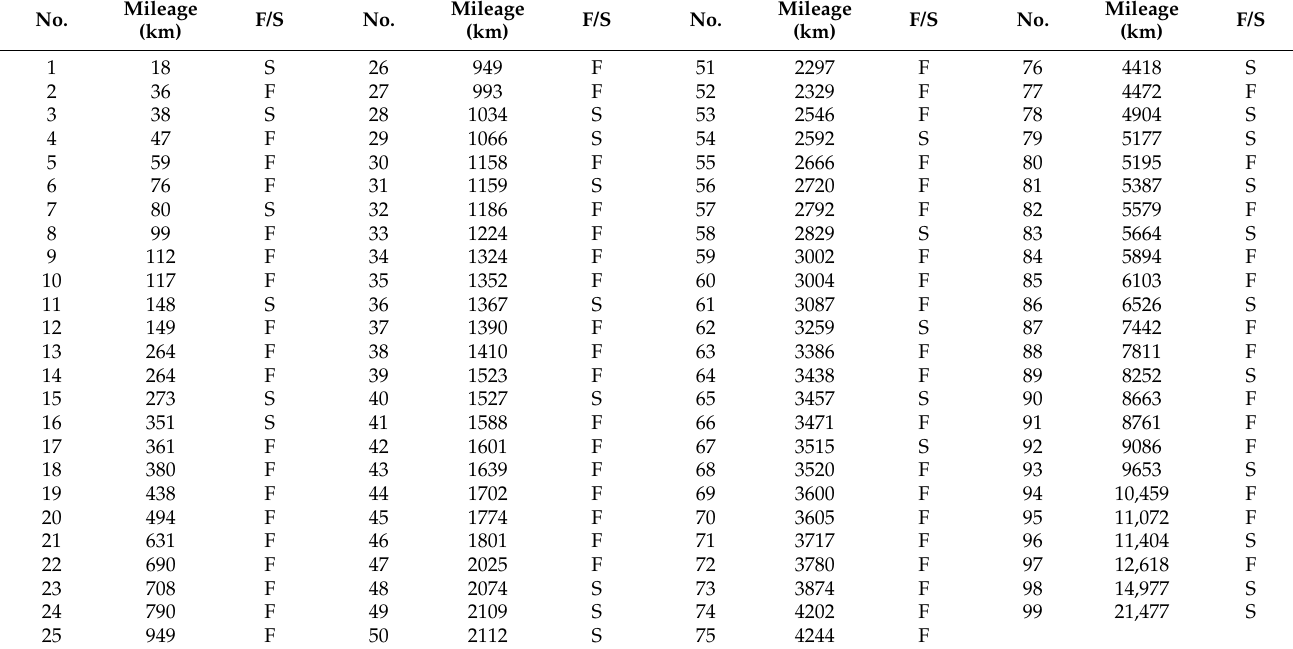
Table 2. Data set of mileages between failures of military